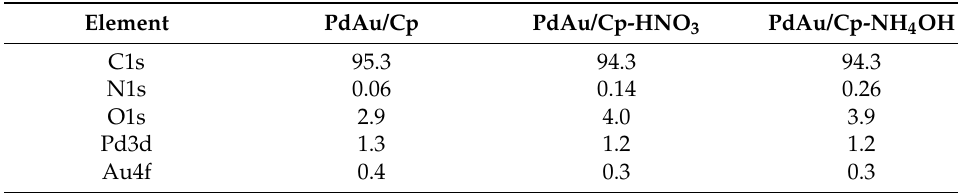
Table 6. Elements surface concentration (at.%) determined by XPS.